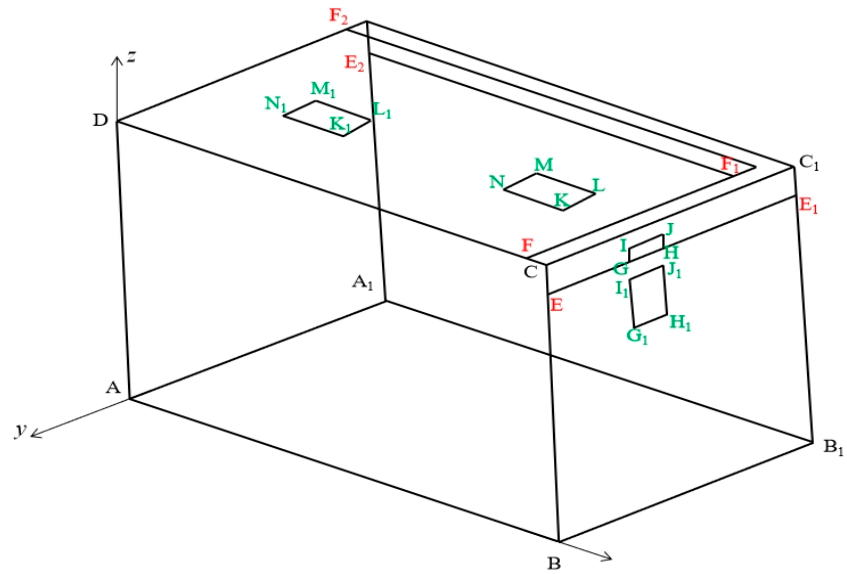
Figure 2. The letters corresponding to cabin geometry. Table 2. The corresponding coordinates of each letter in cabin geometry. The Position of Letters (x, y, z)